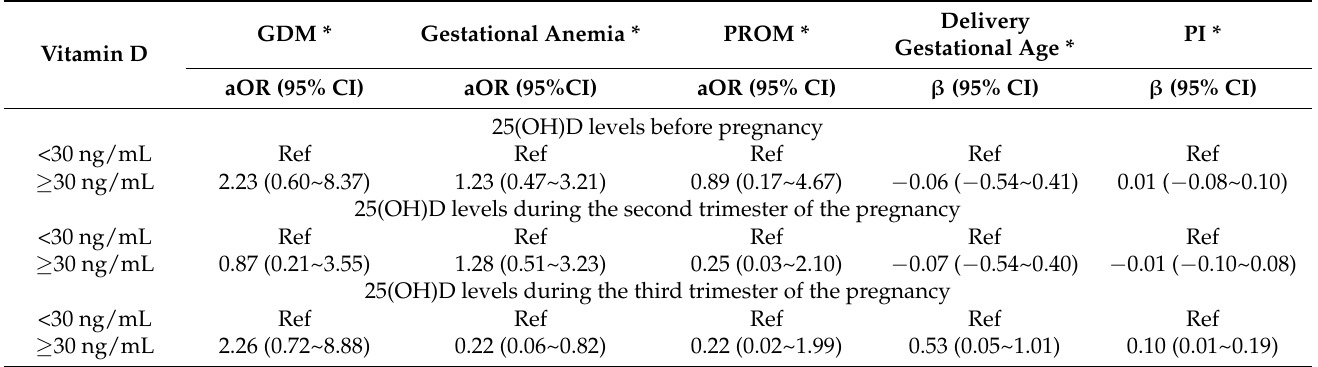
Table 4. Associations of preconception and pregnancy vitamin D levels with pregnancy